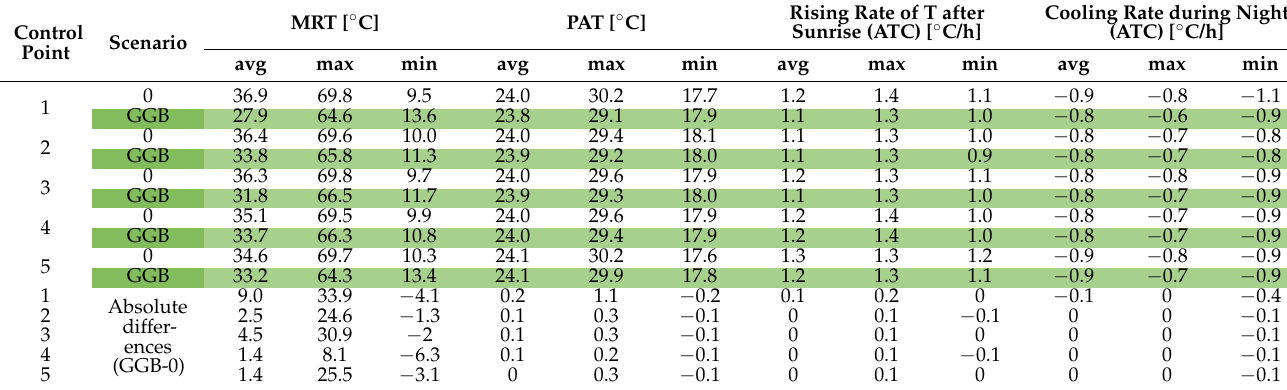
Table 9. The main thermal characteristics of control points (S 0 indicates baseline scenario, S GGB concerns situation after introduction of green–blue